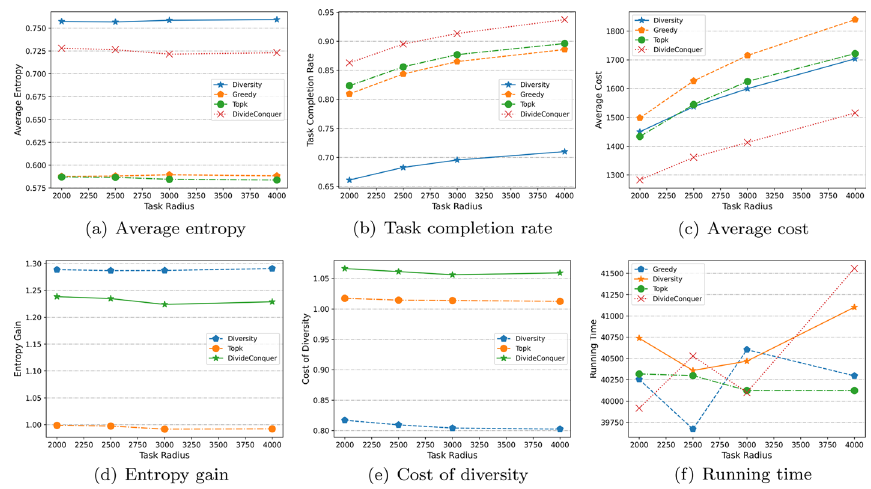
Fig. 3 Effect of the range of task